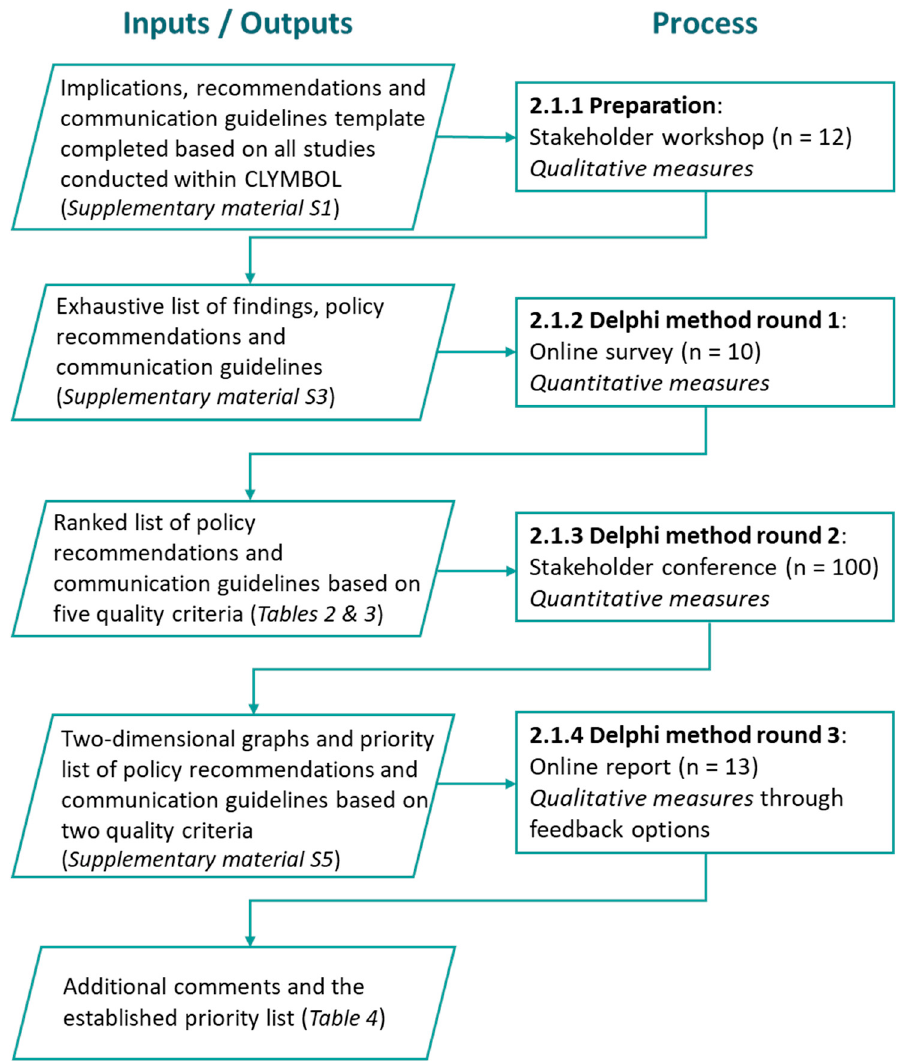
Figure 1. Flow chart of the Delphi study rounds and the corresponding inputs and outputs.